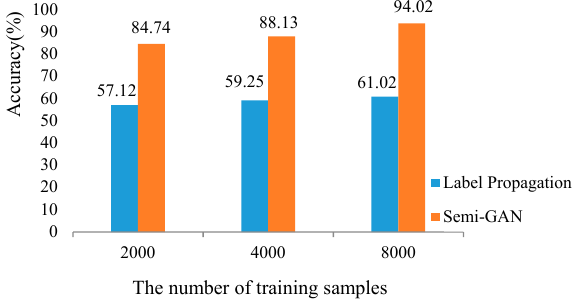
Remote Sens. 2019 , 11 , x FOR PEER REVIEW Figure 6. Test accuracy of di ff erent supervised methods with changed number of training samples. Figure 6. Test accuracy of different supervised methods with changed number of training samples.